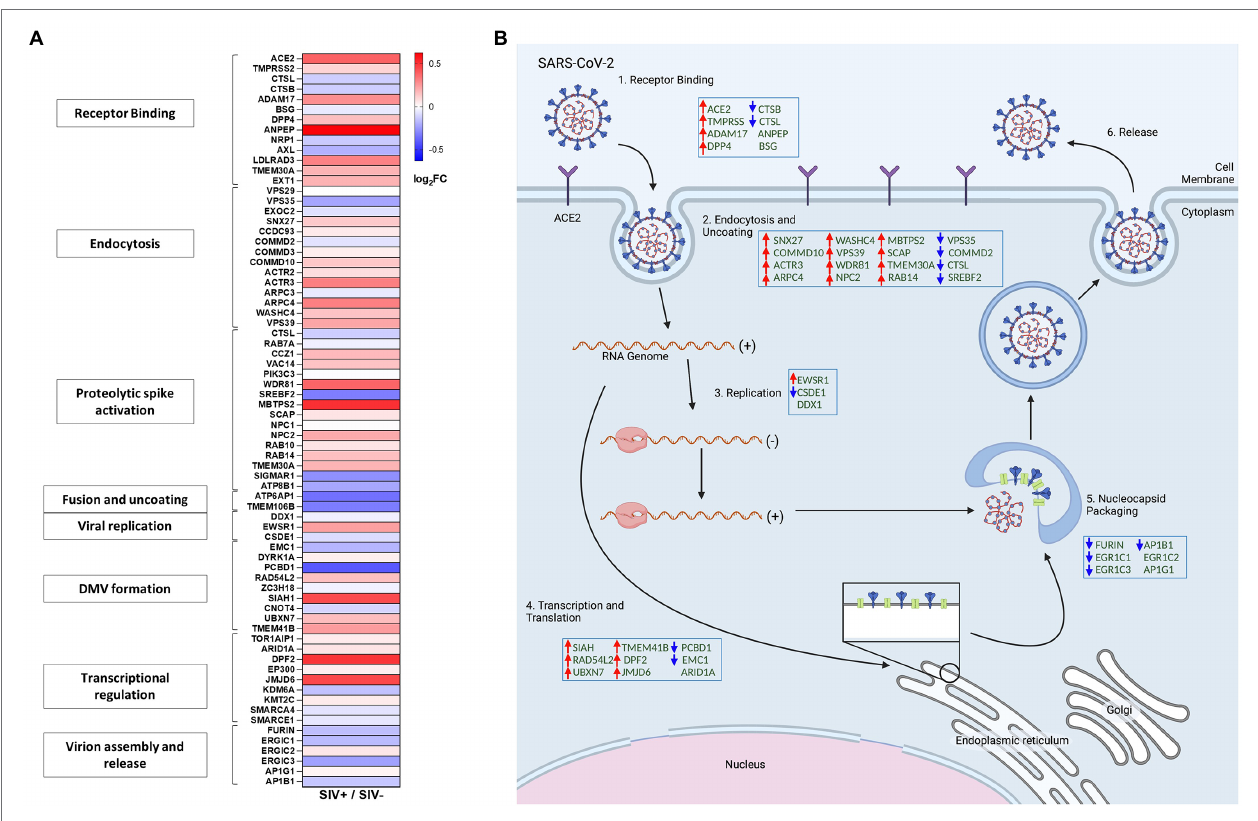
FIGURE 4 | SIV infection modulated gene expression of host factors associated with SARS-CoV-2 replication in the gut. (A) Heatmap displays differential expression of genes associated with SARS-CoV-2 viral activity and replication cycles. (B) Simplified diagram of the SARS-CoV-2 replication cycle. Host factors associated with SARS-CoV-2 replication cycle are modulated by SIV infection in the gut